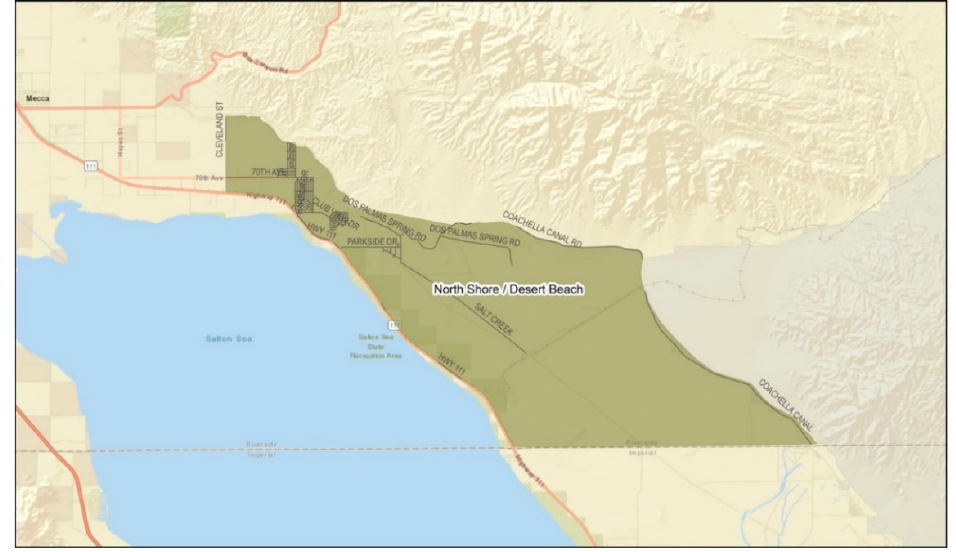
Figure 2. Geographical division of the community of North Shore. (Source: Riverside University Health System—Public Health).